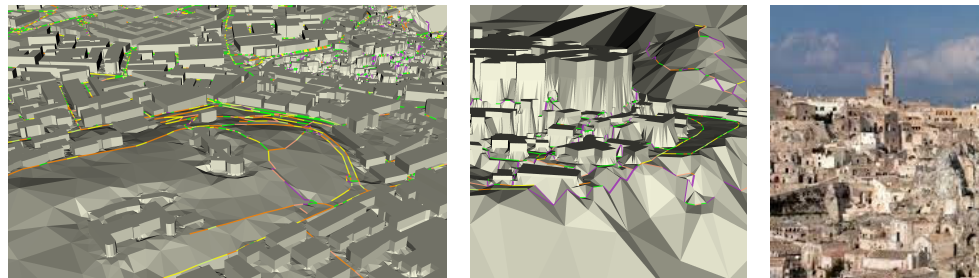
Figure 7. The road network is depicted according to local, per segment slope (from green = null slope to red = maximum slope − 30° in this implementation; values above this threshold are visualised in violet for suggesting unrealistic values). Note that, in the Sassi district ( middle ), the slope computation is much more noisy than in the modern area ( left ), as it suffer from the low resolution with respect to the complex morphology of the area degrading to the river ( right ).